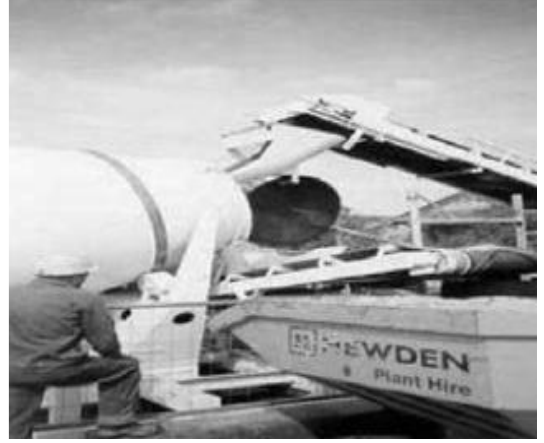
Figure 11. Plastic limit (%) of the soils according to the depth in the four cells: untreated soil > ACT soil > OPC soil > EnvirOceM soil (from Jiangying et al . [38] with permission of Elsevier ).